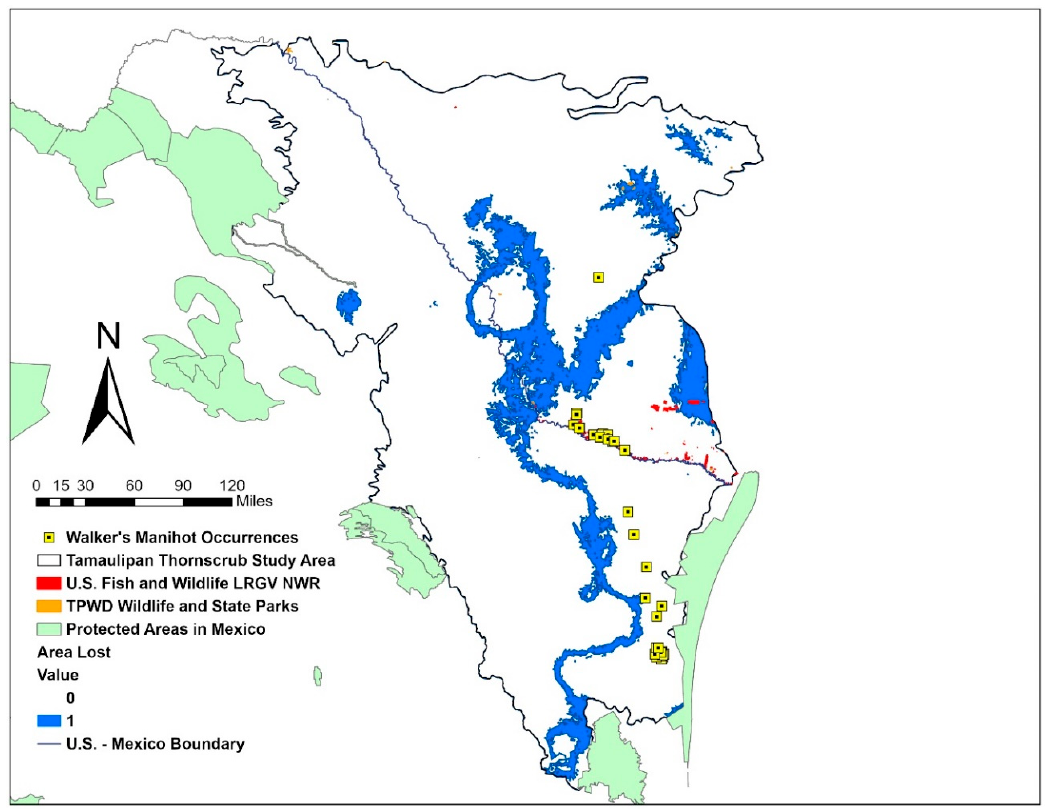
Figure 5. The portion of area lost (blue) as a result of climate change for the CMIP5 RCP 4.5 2070 model that had the highest predicted loss of distribution − 14.37%. The known occurrences of Manihot walkerae were shown to not be affected, but some U.S. Fish and Wildlife LRGV NWR protected areas (red) in the northeastern portion of the study area are predicted to no longer be suitable for M. walkerae in the future. No protected areas in Mexico are shown to overlap with suitable areas of distribution of M. walkerae at present and in the future.